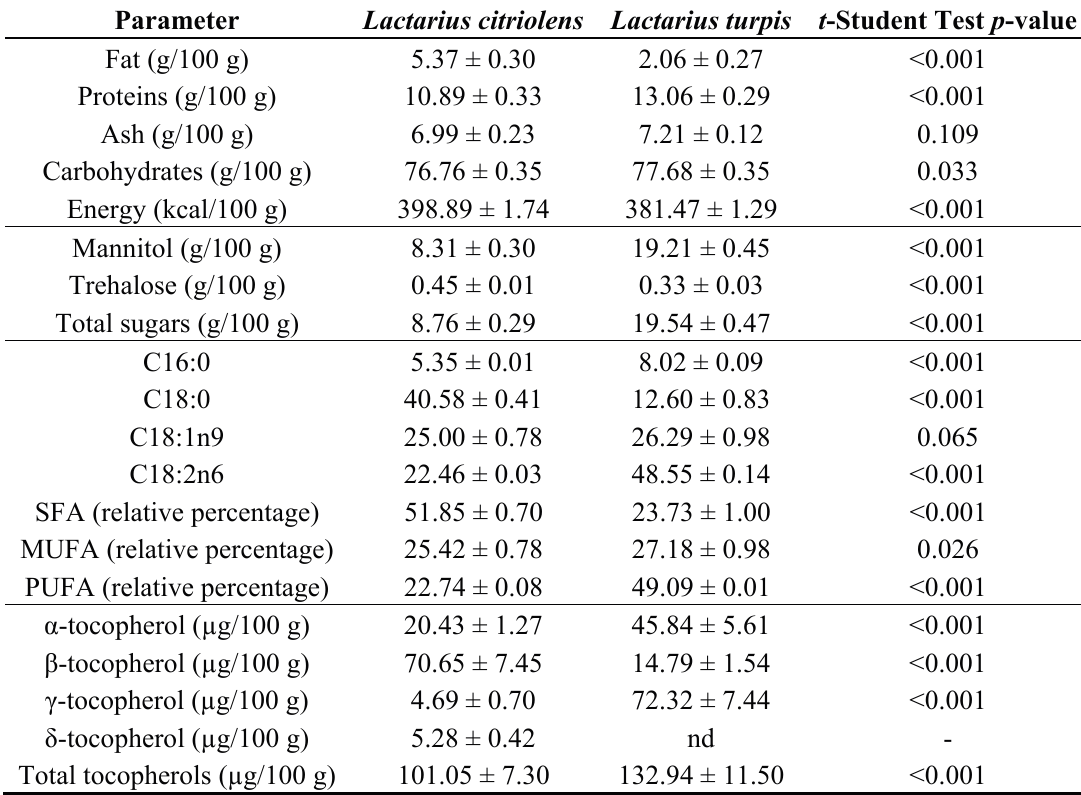
Table 1. Macronutrients, free sugars, fatty acids and tocopherols of the fruiting bodies expressed in dry weight basis (mean ±